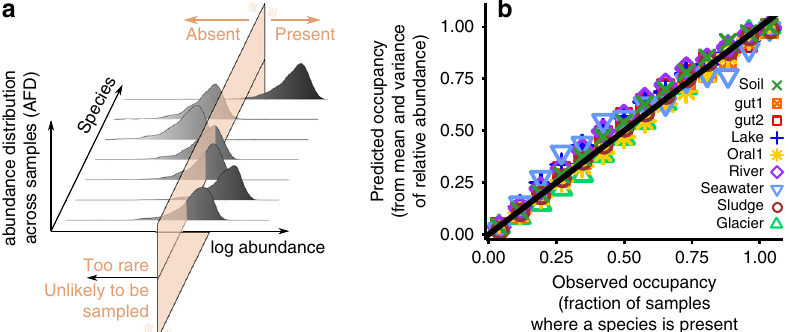
Fig. 2 The AFD predicts the presence/absence of species from fl uctuations of abundance. a Relationship between fl uctuation in abundance and the absence of species. The fl uctuations of species abundances across communities (AFD) are Gamma distributed (Fig. 1), which implies that species are absent only because of fi nite sampling. b Tests the prediction, by comparing the occupancy of species (the fraction of communities where a species is presence) in different biomes with what expected from independent sampling from Gamma distributed relative abundances (Supplementary Note 4 and Supplementary Fig.